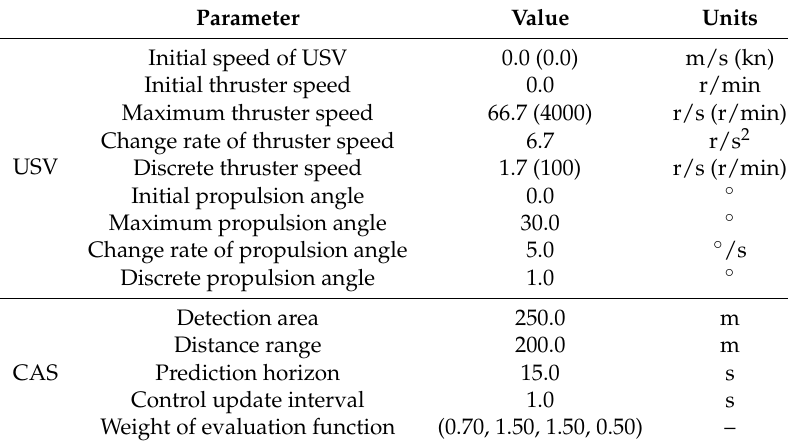
Table 1. Parameter information about the USV and